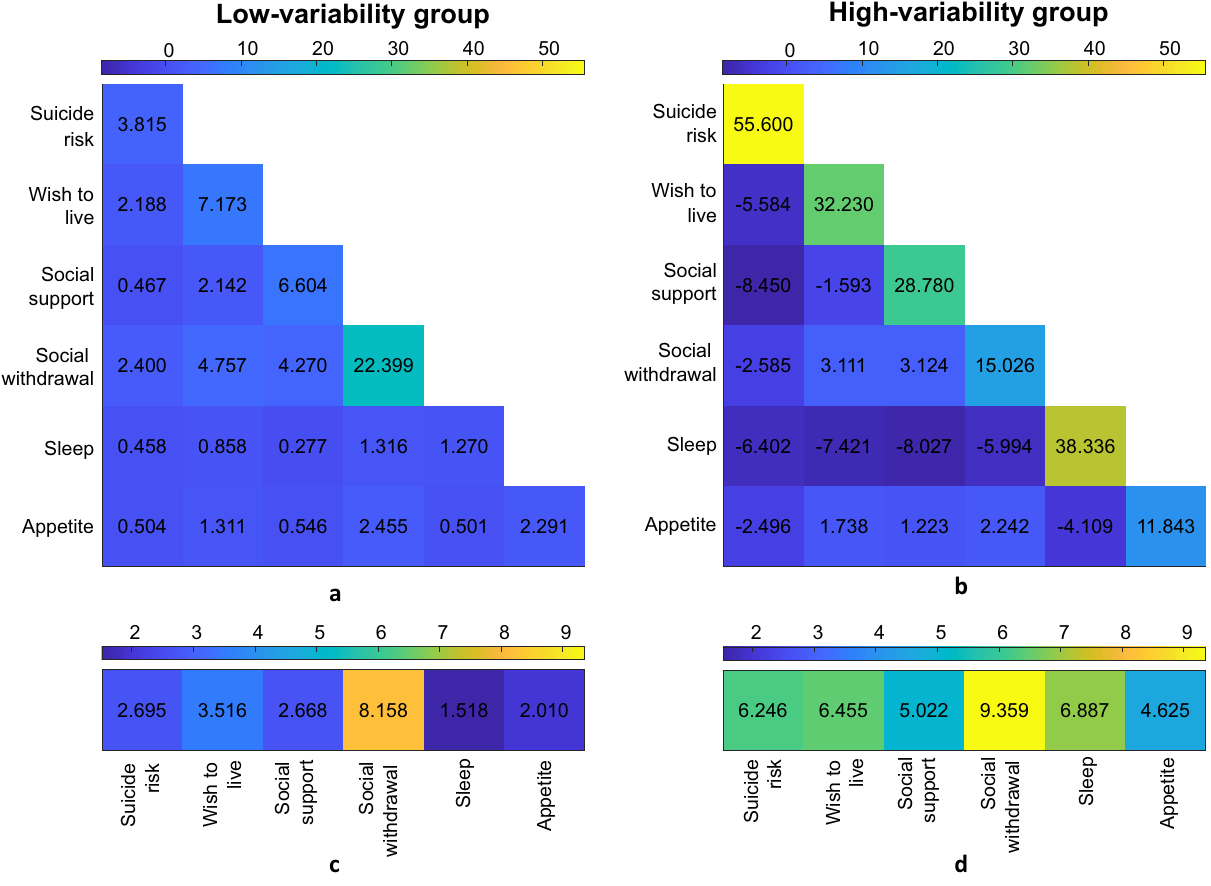
Figure 3. The variability covariances and means of the low-variability group are shown in insets ( a,c ), respectively. The variability covariances and means of the high-variability group are shown in insets ( b,d ), respectively. Recall that they measure variability , not absolute values. For simplicity, only the lower triangular and main diagonal region of the variability covariance matrices is shown. Negative covariances indicate that increased variability in one domain is associated with lower variability in the other. The colormaps are the same across the groups to allow visual comparison, and they range from the overall maximum and minimum values of those qualities. Colormaps are shown at the top of each